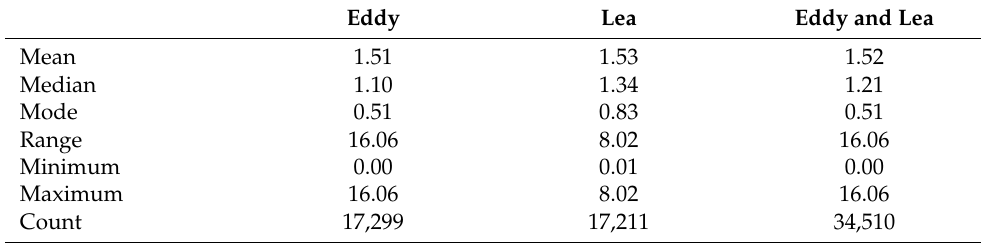
Figure 5. Histogram illustrating the distribution of the minimum distance from oil and gas wells to the nearest SWD well. Table 4. Descriptive statistics of distances (in miles) of oil and gas wells to the nearest SWD well. Eddy